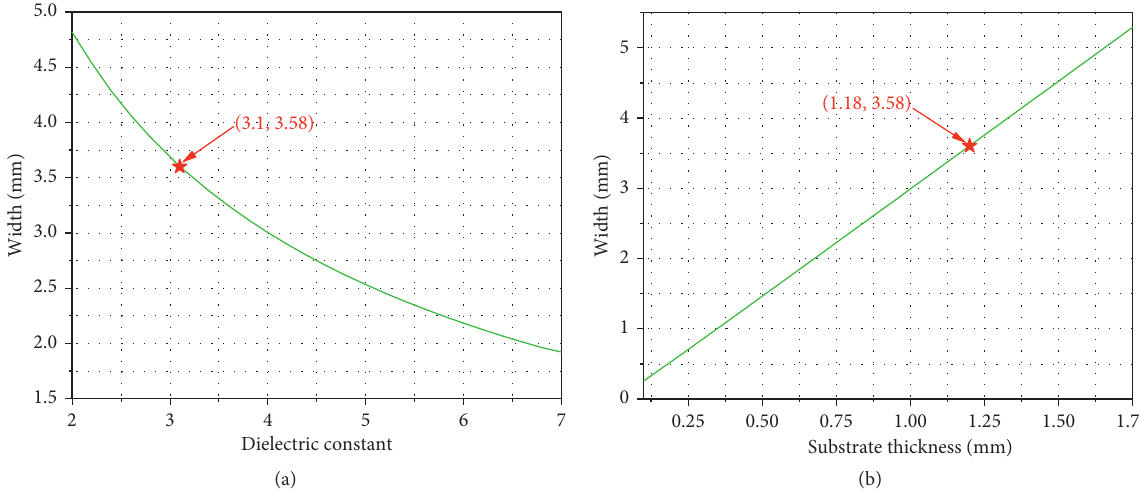
Figure 10: (a) The relationship between the dielectric constant of the substrate and the width of the external microstrip line ( H � 1.5mm, Z � 50 Ω ); (b) the relationship between the thickness of the substrate and the width of the external microstrip line ( ε � 2.65, Z � 50 Ω ). Table 1: Several commonly used PCBS.